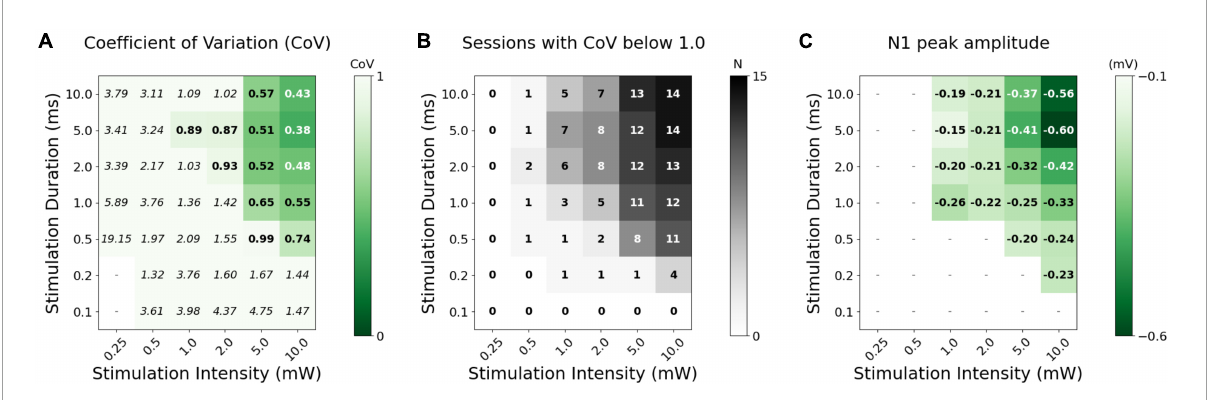
FIGURE4 Stimulus-response characteristics of the N1-component of the transcallosal evoked LFP in left M1. (A) Median of robustness of the N1 response across animals, determined as coefficient of variation (CoV; SD/mean) of peak N1 amplitude for individual recorded trials. We selected a CoV-threshold for robustness of the N1 peak of 1.0 (values below threshold are marked in bold). (B) Number of animal sessions with robust conditions (CoV < 1.0). (C) Median N1 peak amplitude (mV) of robust conditions (CoV < 1.0) with N ≥ 20% of the animal sessions. Median values are only shown where there is ≥ 20% animal sessions for a given